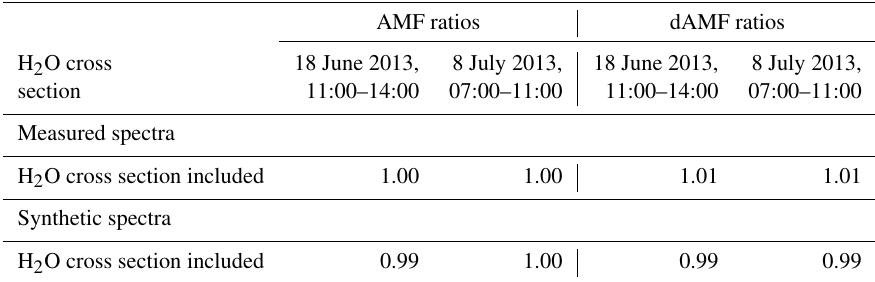
Table A21. Average ratios of O 4 (d)AMFs derived for the analysis including a H 2 O cross section vs. those for the standard analysis (no H 2 O cross section) for the standard analysis (only one O 4 cross section) for the middle period on each selected day (top: results for spectra measured by the MPIC instrument; bottom: results for synthetic spectra when taking into account the temperature dependence of the O 4 cross